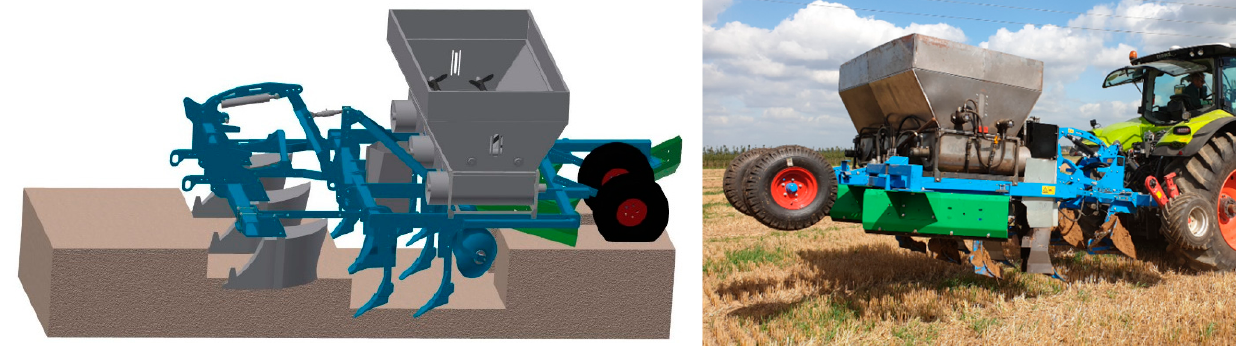
Figure 12. The developed prototype for Soli 3 subsoil melioration.